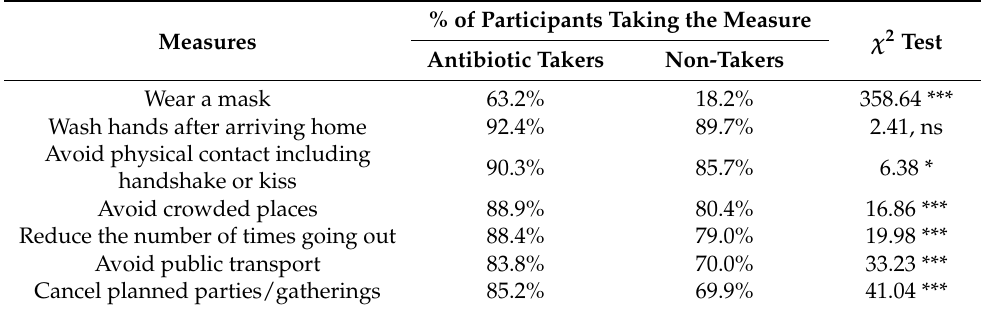
Table 2. Percentage of participants taking various measures against COVID-19 ( n = 2217).